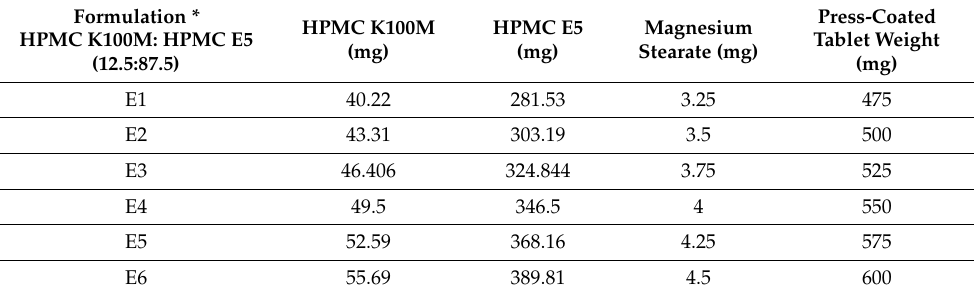
Table 17. The formulations of E1 to